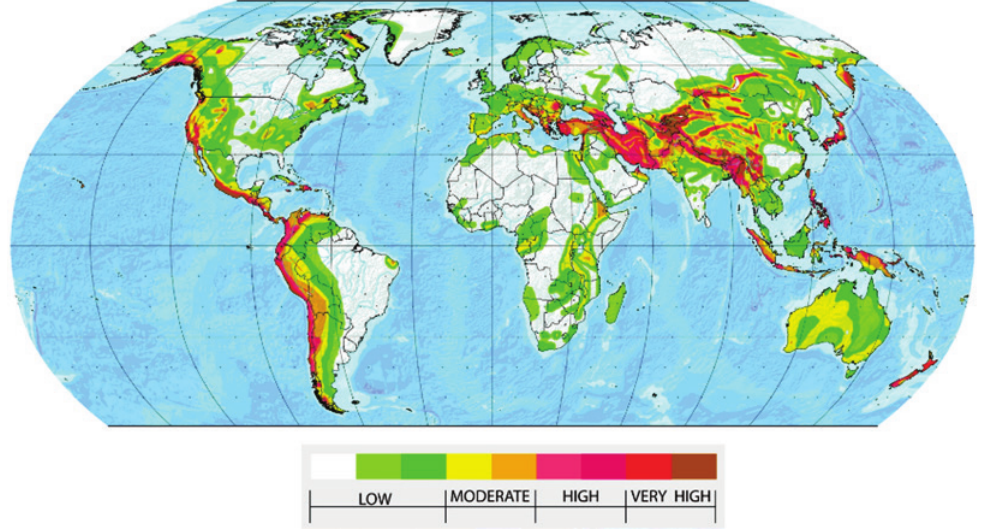
Figura 1 Mapeamento da aceleração sísmica horizontal característica no mundo Fonte: Global Seismic Hazard Assessment